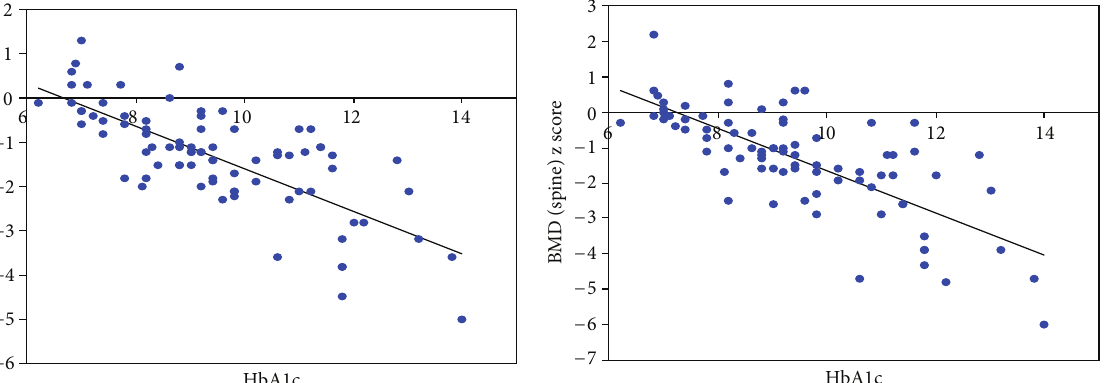
(b) Correlation of lumbar spine BMD 𝑧 score with physical activity 𝑟 = 0.54 ; 𝑃 < 0.05